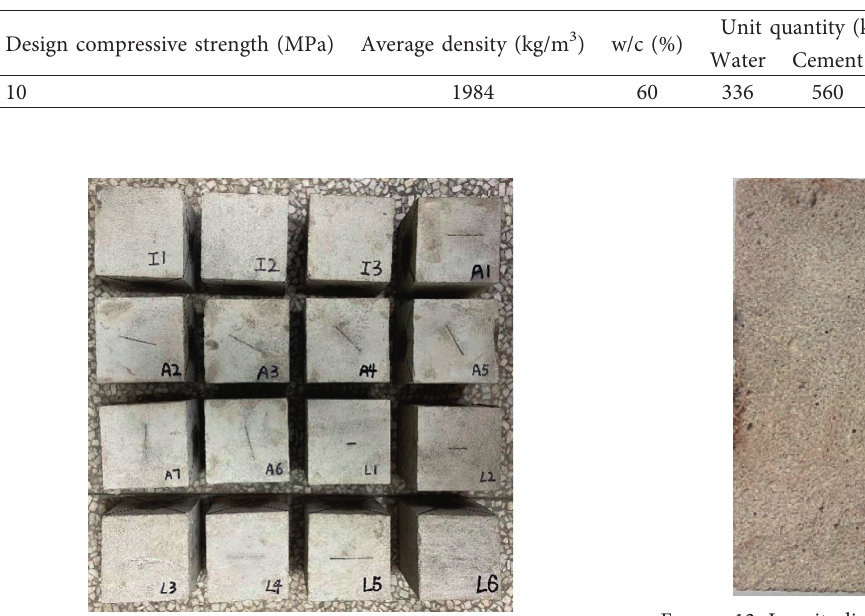
Table 3: Details of mixture proportions and physical properties of the mortar specimens.